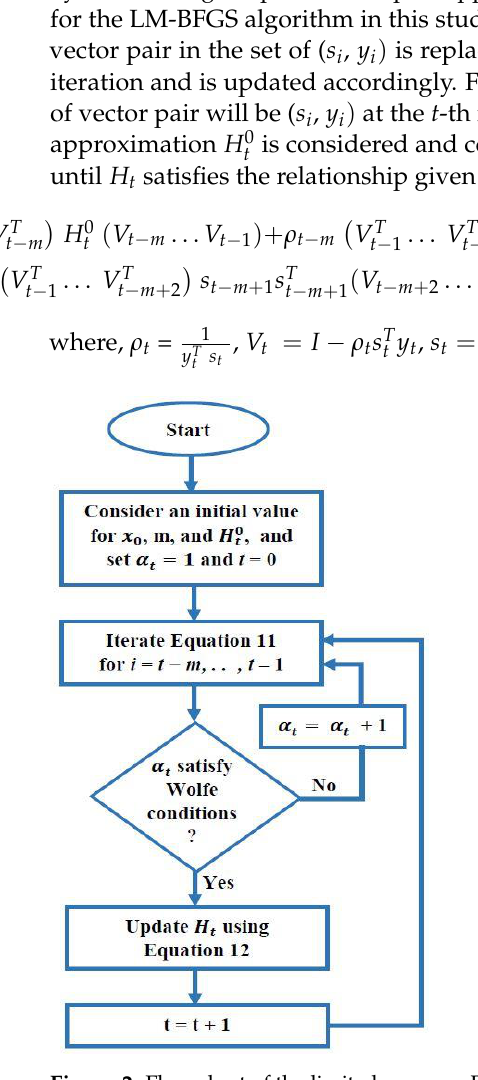
Figure 2. Flow chart of the limited-memory Broyden–Fletcher–Goldfarb–Shanno (LM-BFGS) algorithm.